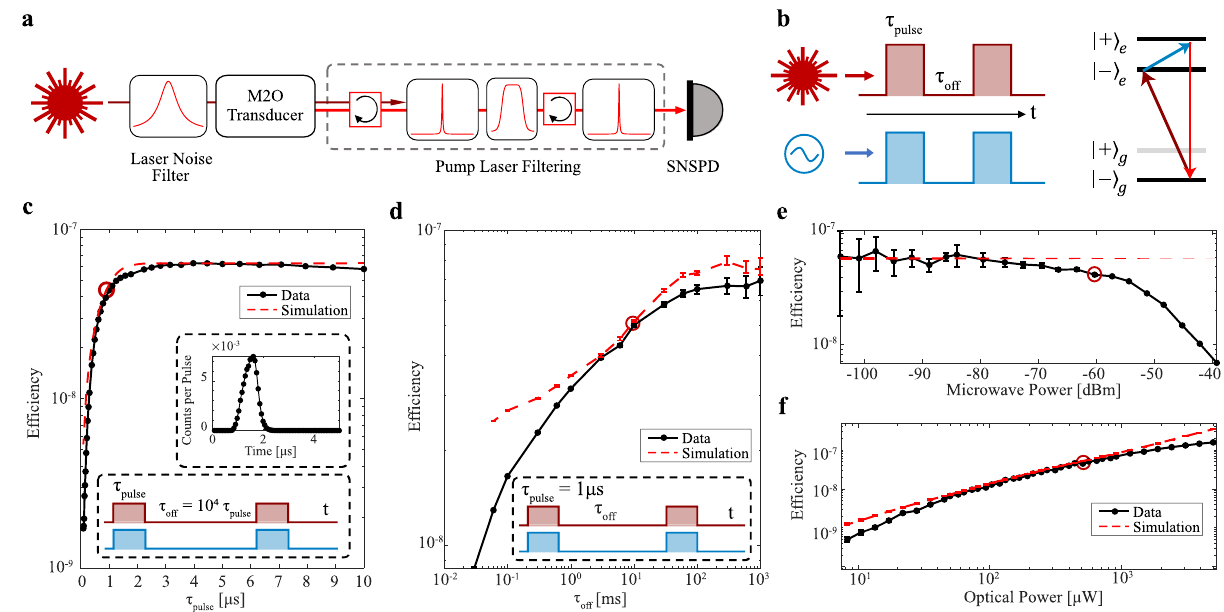
Fig. 3 | Pulsed excited state transduction ef fi ciency with photon counting detection. a Schematic of the pulsed transduction setup using photon counting detectionby fi lteringoutthepumplaser.Beforethetransducerone fi lterwasused to remove broadband noisefrom the laser,while afterthe transducer the two high fi nesse Fabry-Perot fi lters and a set of broadband spectral fi lters were used to remove the main pumplaser tone and broadband noise leakage. b Pulse sequence con fi guration, where we have a square pulse of length, τ pulse , and an off time between pulses of length, τ off , for both the optical and microwave pulses simul- taneously. The levelstructureusedforthe excitedstate transduction process used inc-f. c )Pulsedtransductionef fi ciencyasafunctionofthepulselengthwitha fi xed =0 : 01%). Inset shows the time domain signal of the 1 µ s duty cycle ( τ pulse τ off